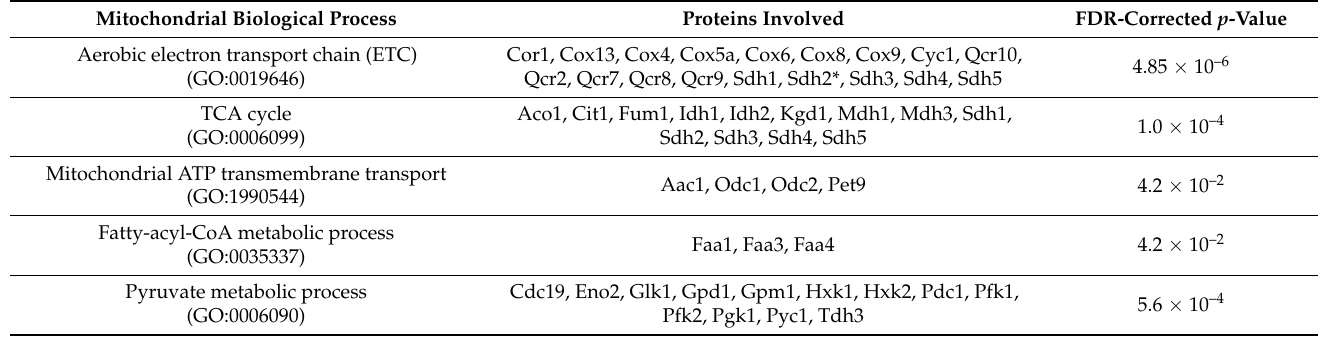
Table 2. Mitochondrial processes affected by proteins that significantly decrease in abundance in yme1 mutant